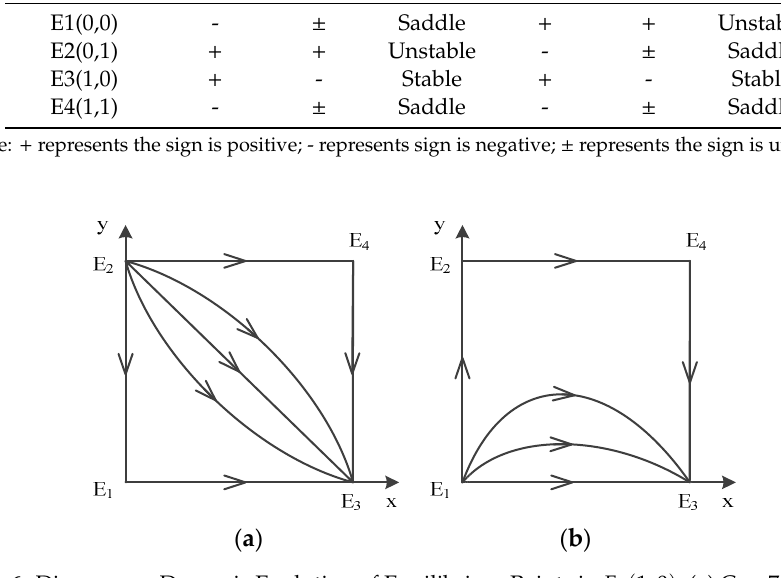
Figure 6. Diagram on Dynamic Evolution of Equilibrium Points in E 3 ( 1,0 ) , ( a ) Case7 ( b ) Case